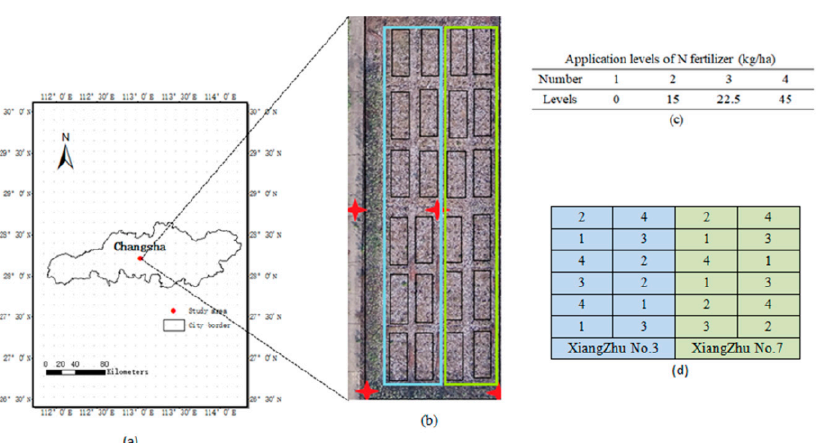
Figure 1. Study area and arrangement of the experimental sites: ( a ) geographic map of the study area, ( b ) experiment fields for ramie, ( c ) nitrogen fertilizer application levels represented by number, and ( d ) nitrogen fertilizer application levels in each plot.